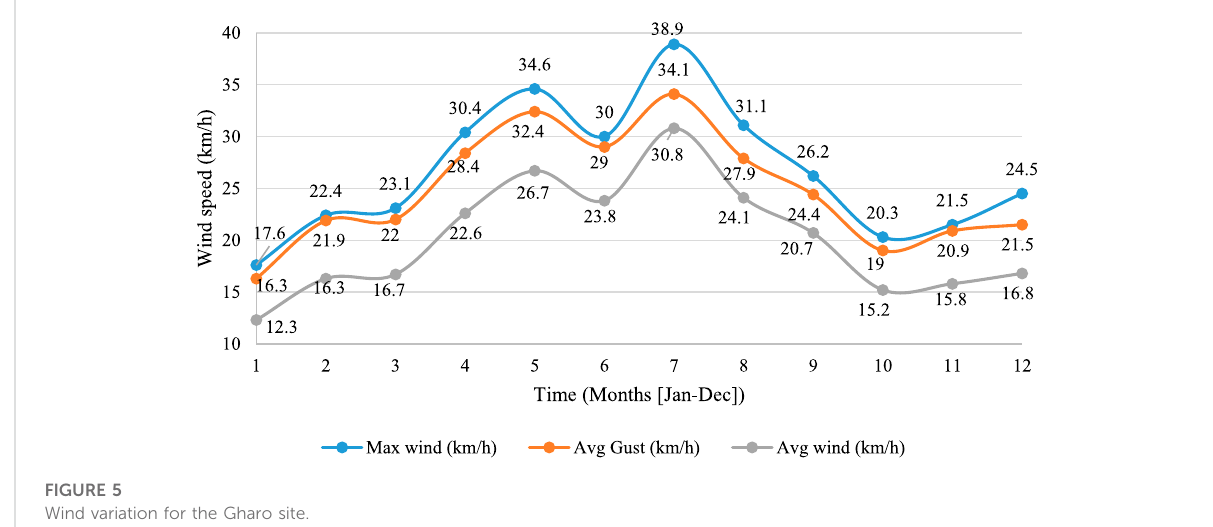
FIGURE 5 Wind variation for the Gharo